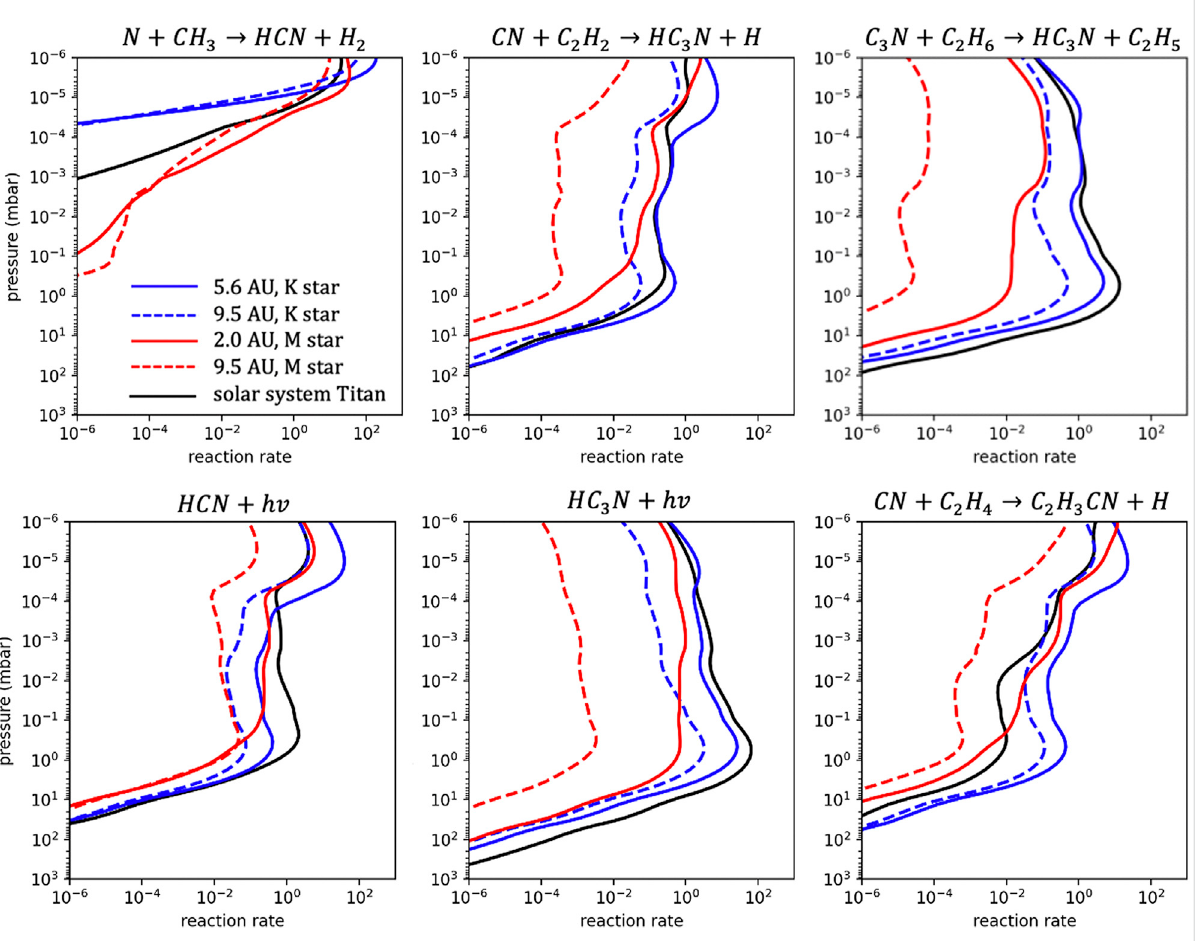
Reaction rates (cm − 3 · s − 1 ) of dominant production and destruction reactions for -CN species. Black lines represent solar system Titan, solid red lines represent Titan around an M-Dwarf at 2 AU, dashed red lines represent Titan around an M-Dwarf at 9.5 AU, solid blue lines represent Titan around a K star at 5.6 AU, and dashed red lines represent Titan around a K star at 9.5